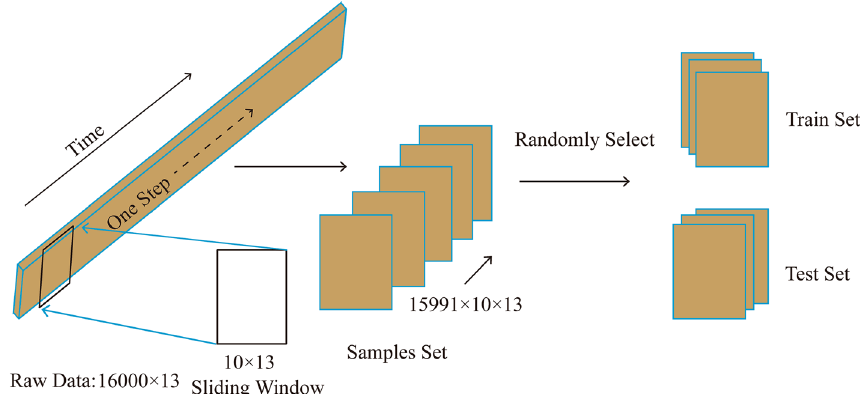
Fig. 2 The time series integration scheme adopted by Teng et al (2020)